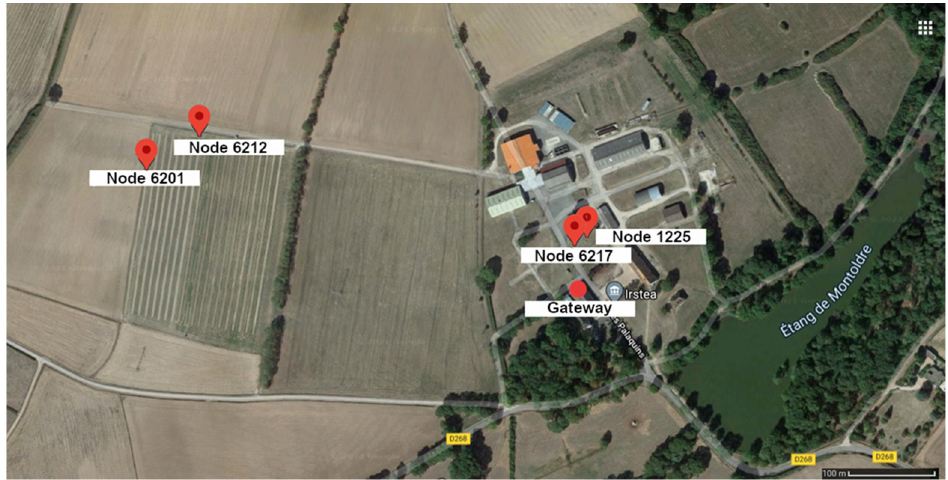
Figure 10. Location of nodes and the gateway on Montoldre site 3.4.3. Sensors ( Image ©2023 Google, Images ©2023 CNES/Airbus ).